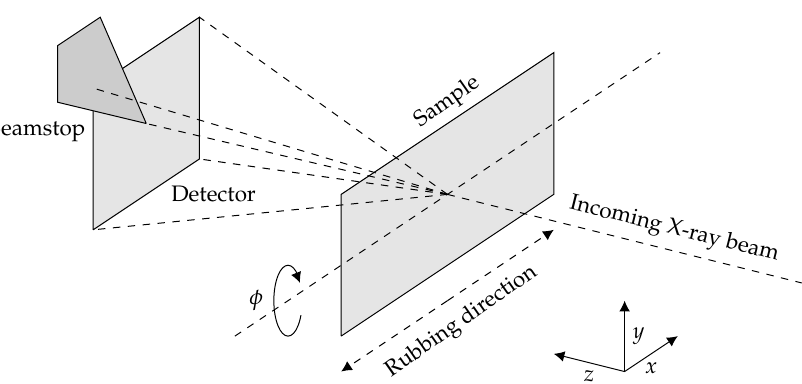
Figure 2. A schematic representation of the small-angle X-ray scattering (SAXS) setup. Here, the monolayers of colloidal superballs are rotated around the x -axis. The angle of rotation around this axis is denoted by φ . The incoming X-ray beam travels along the z -axis. The scattering patterns are imaged in x , y -space. A beam-stop was used to prevent damage to the detector. Note that this schematic representation is not drawn to